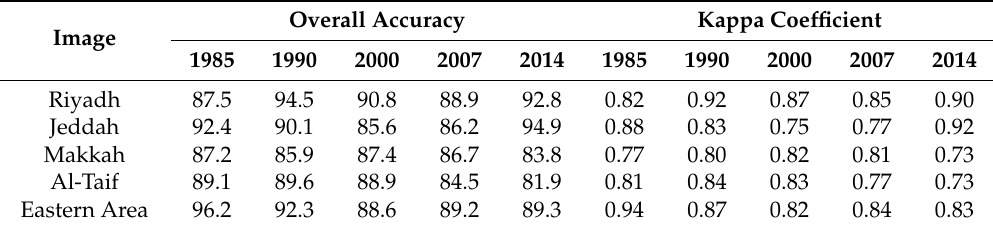
Table 4. List of overall accuracies and Kappa statistics of the classified images. Overall Accuracy Kappa Coefficient Image 1985 1990